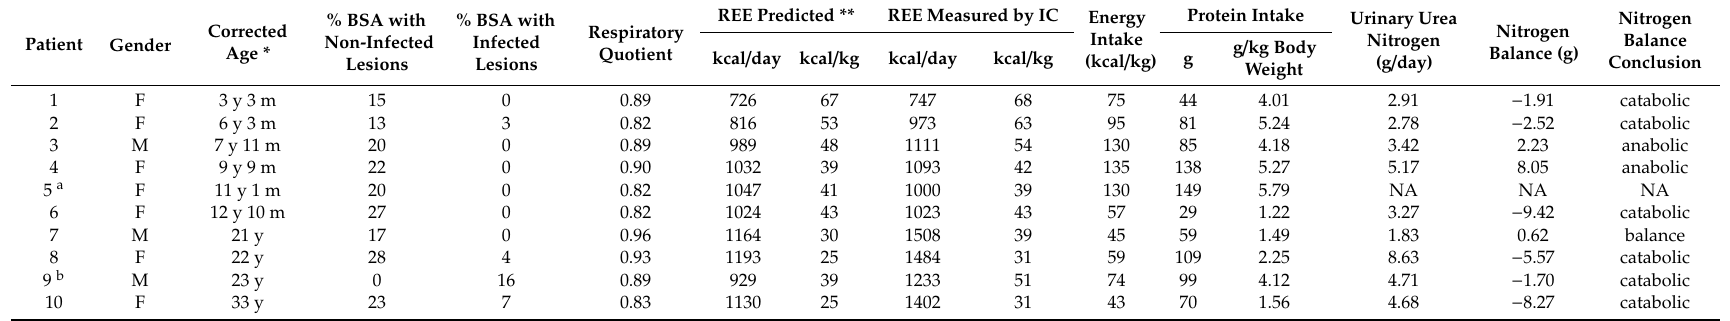
Table 3. Measured and predicted resting energy expenditure, energy intake, nitrogen balance, and their components in subjects with